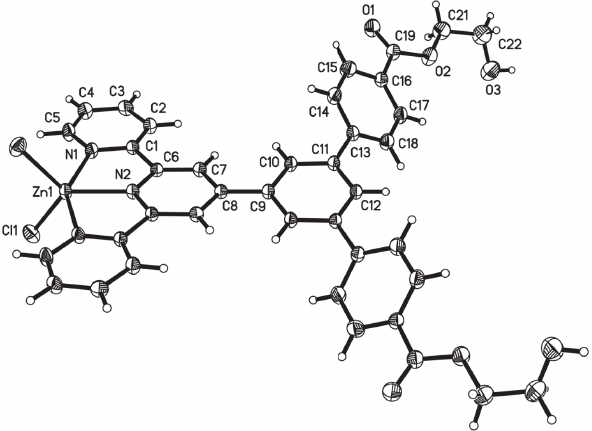
Table 2: Fractional atomic coordinates and isotropic or equivalent isotropic displacement parameters (Å 2